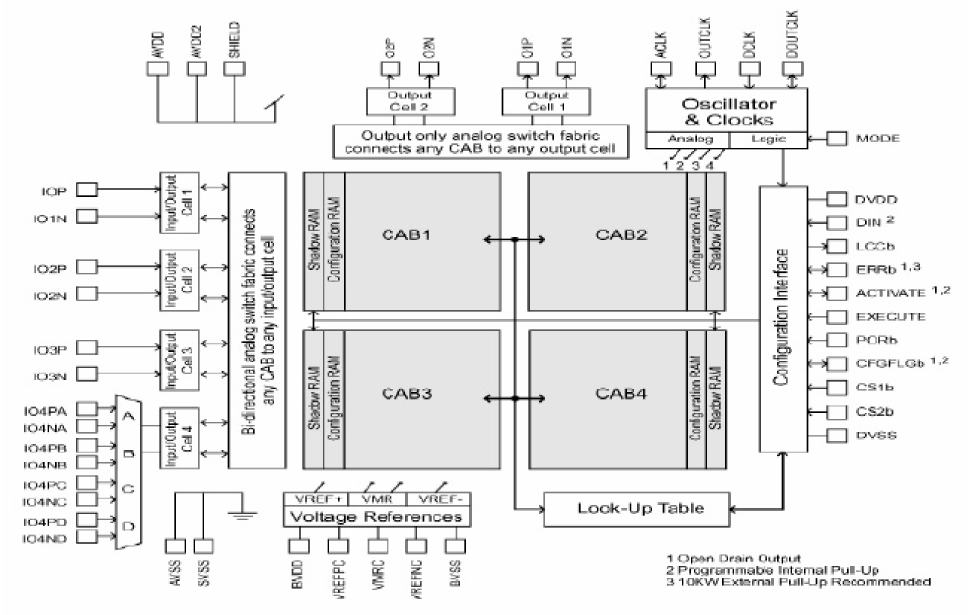
Figure 4. Anadigm AN221E04 Architecture.